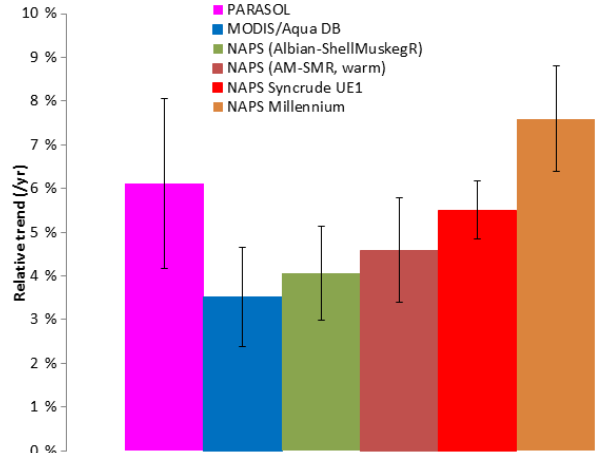
Figure 6. Relative trend in annually averaged PM 2 . 5 mass density calculated using NAPS PM 2 . 5 data for three locations, namely the merged Albian mine and Shell Muskeg River data set (2002–2015), Millennium mine (2002–2014) and Syncrude UE1 (2003–2014), or in satellite AODs in the vicinity of Shell’s Albian and Muskeg River mines (see Fig. 4 and Sect. 3). The trend is also determined for the NAPS PM 2 . 5 merged Albian mine–Shell Muskeg River (AM- SMR) data set, limited to the warm season (April to October). Trend uncertainty is indicated with a vertical bar ( ± 1s.